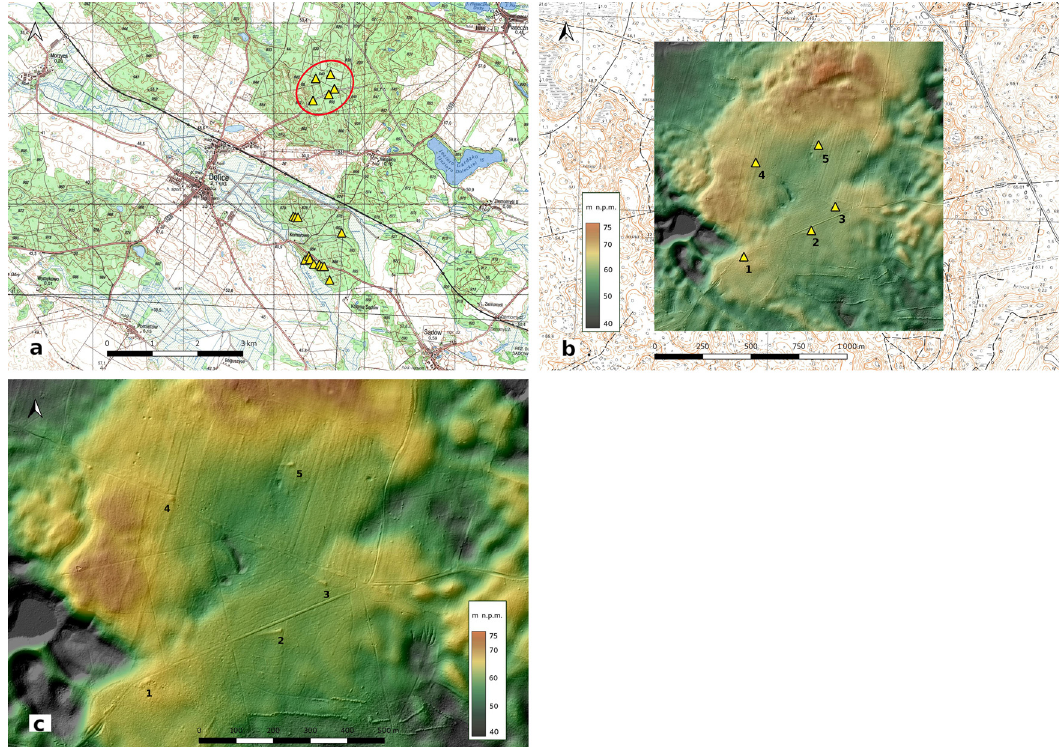
Figure 7: The Dolice - Rondo Lucjana megalithic group shown among other groups of megalithic tombs in the Dolice megalithic group ( a ) , the group presented on a hypsometric map fragment ( b ) and its digital terrain model in hypsometric colours ( c ) ( M. Schiller )